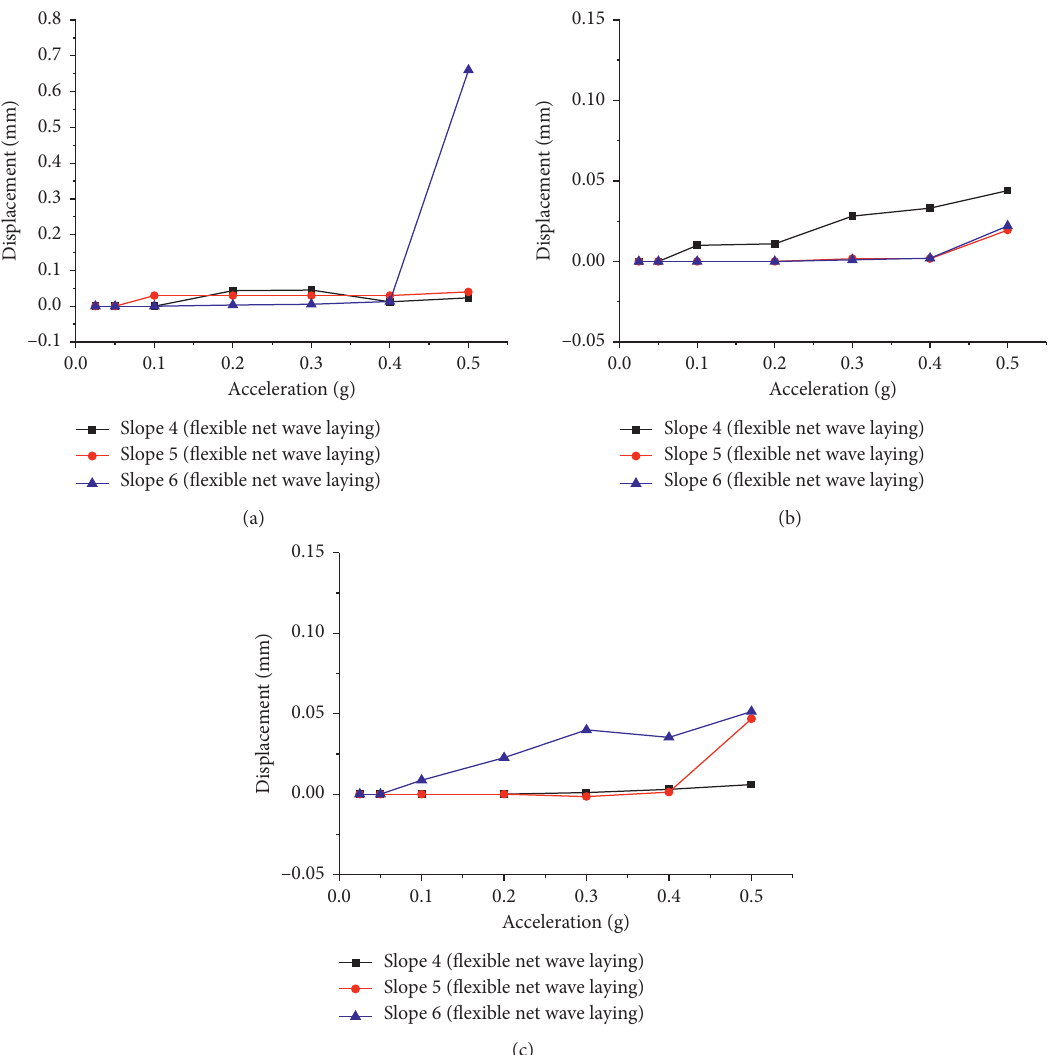
Figure 16: Substrate layer displacement at a slope of 60 ° . (a) H � 1.3 m. (b) H � 0.8m. (c) H �